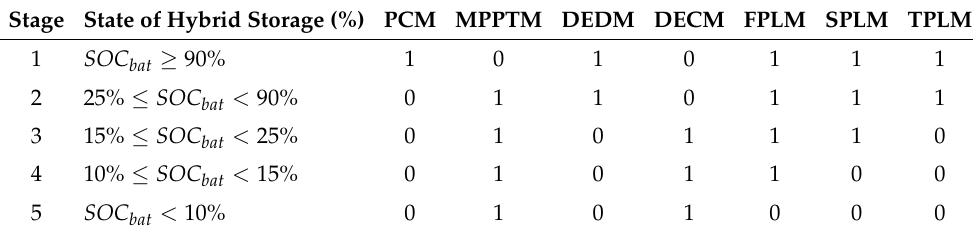
Table 2. Power management operating